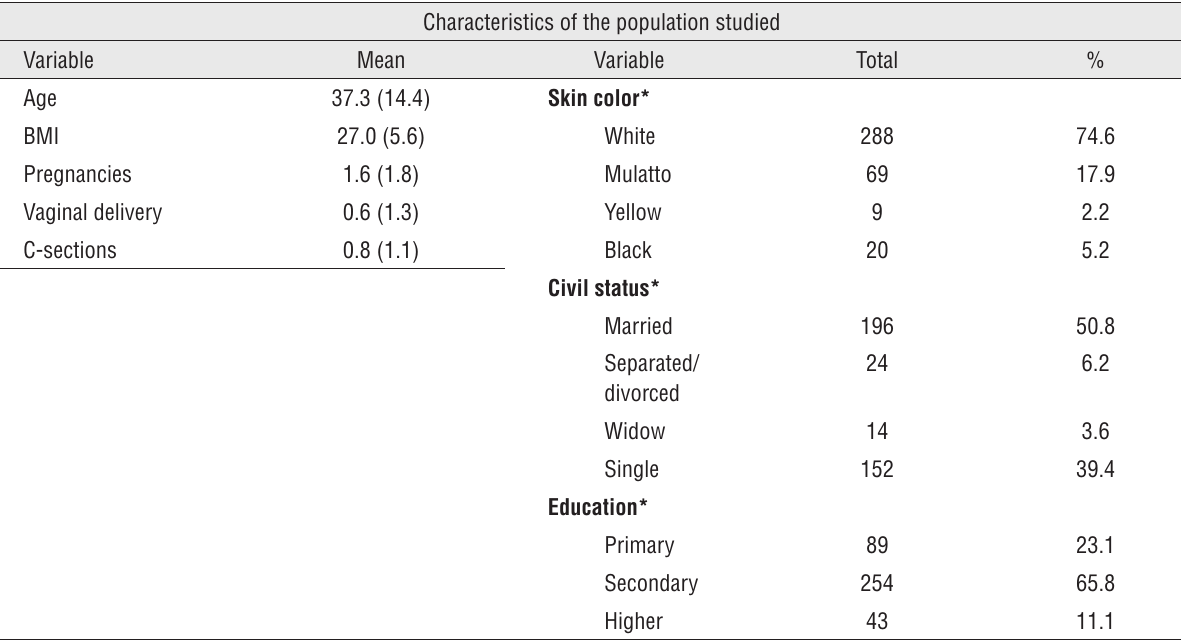
Table 1 - clinical and demographic data of the study